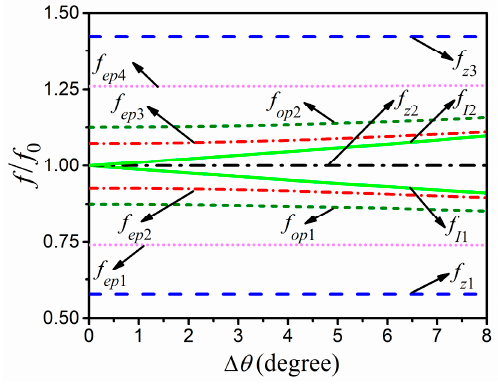
Figure 5. TPs and TZs with respect to different Δ θ .